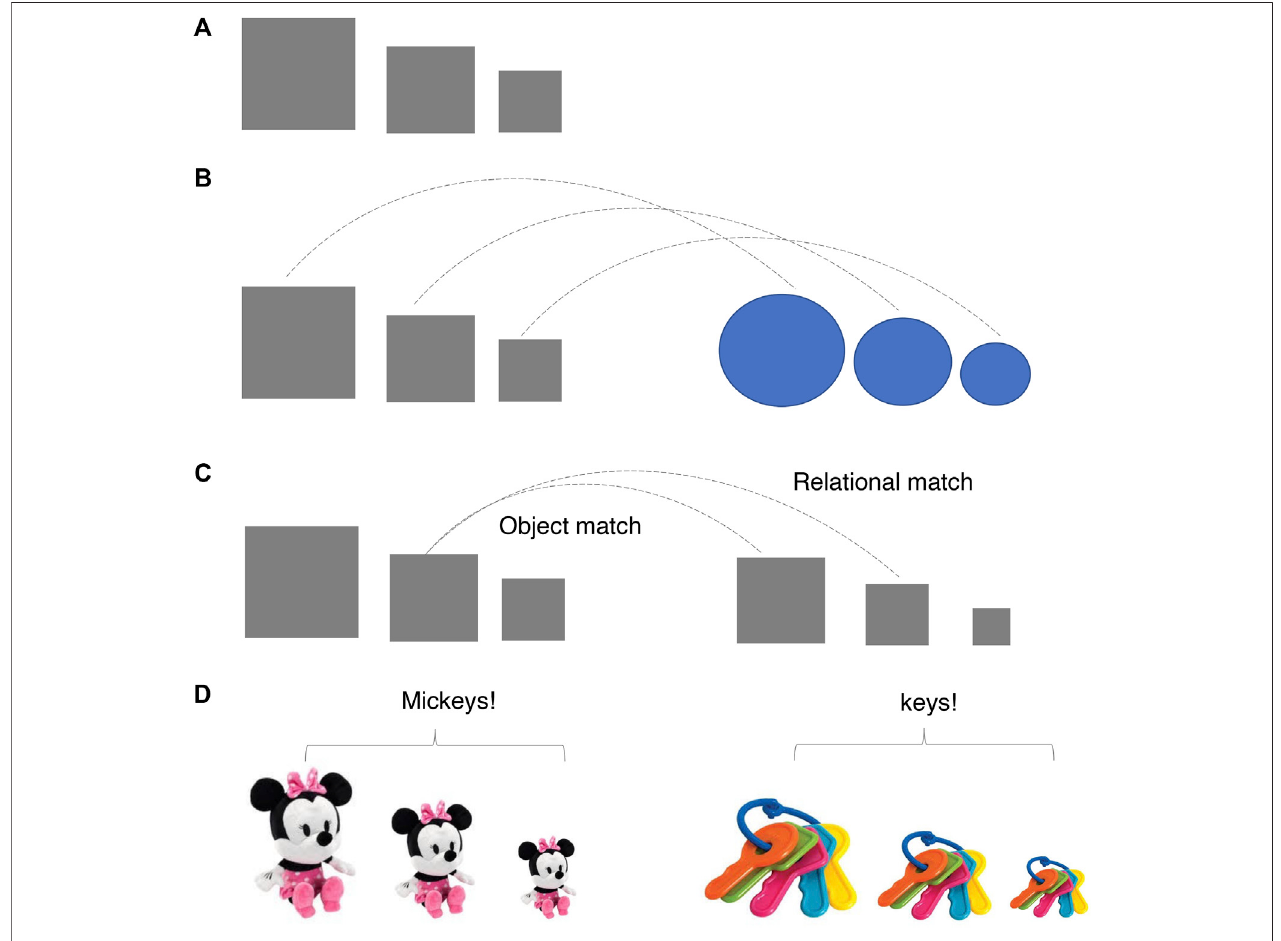
FIGURE 1 | The challenges and ways to extract relational structures: (A) Extracting relational patterns from a single exemplar is dif fi cult for young children. (B) Aligningand comparing two analogs that share the samerelational pattern can help. (C) Alignment based on relational match is dif fi cultto establish with the presence of object match. (D) Richly detailed components often draw learners ’ attention to object identities rather than relational